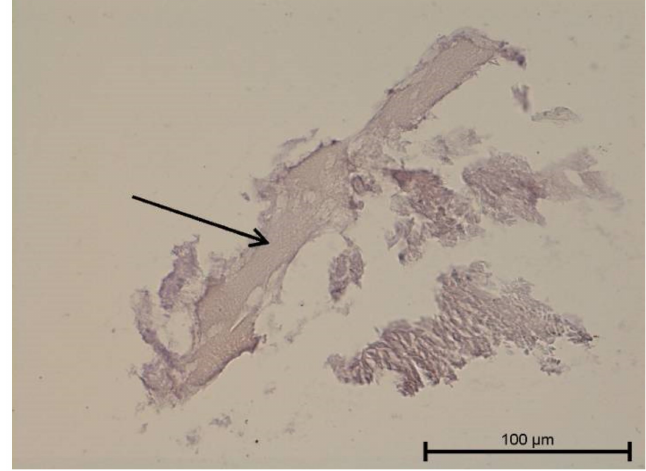
Figure 16. Light microscope image. Carious tooth. Anti-VEGFR 3—weak positive (black arrow). Mag. 400 × .